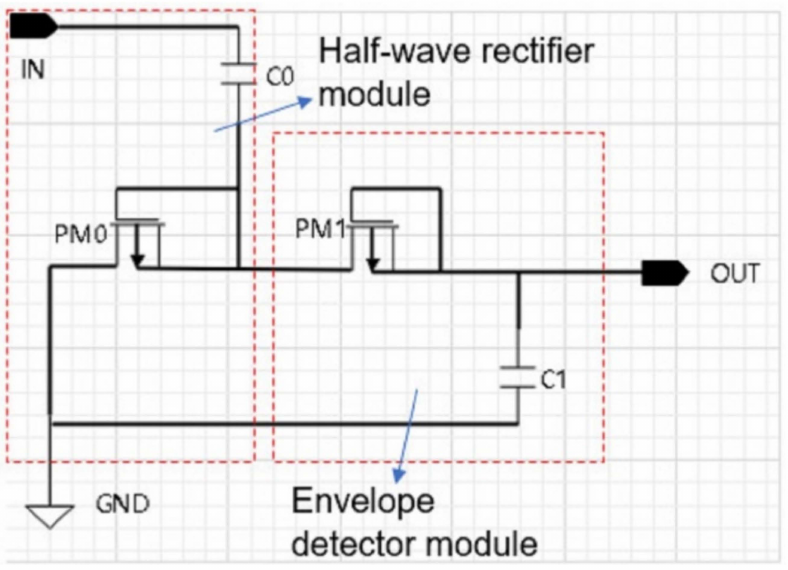
Figure 5. CMOS low threshold charge